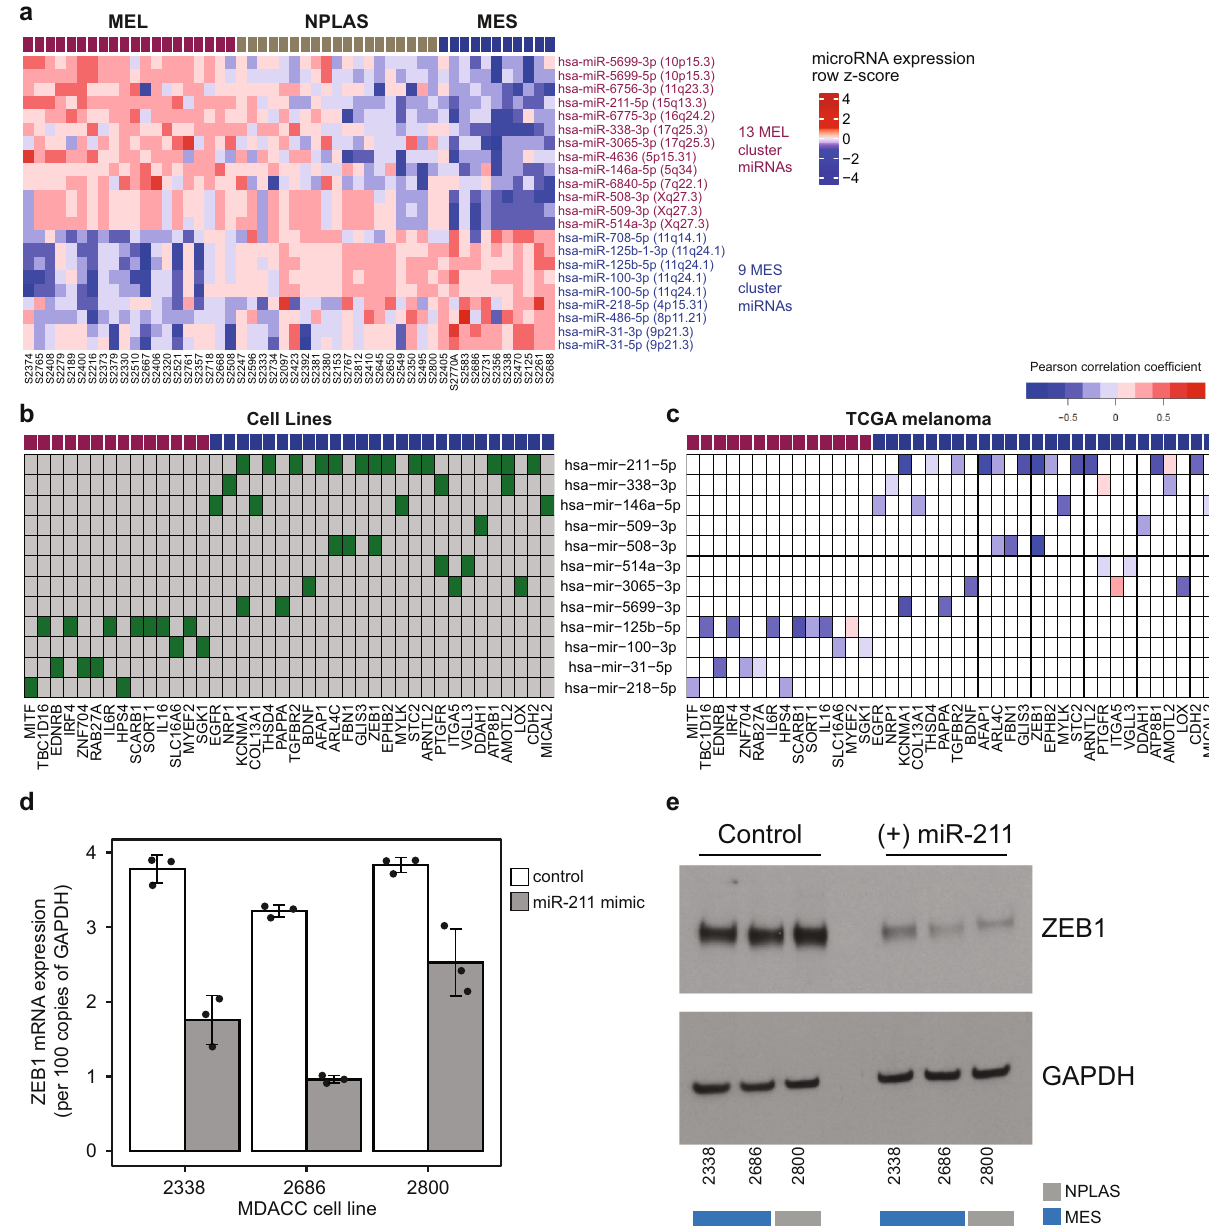
Fig. 5 Inverse associations between MEL and MES gene expression and mature strand miRs in cell lines are preserved in melanoma tumors. a Heatmap depicting expression of miRs differentially expressed between MEL and MES early passage MDACC melanoma cell lines ( n = 53). b Inverse Pearson correlations between abundances of miRs differentially expressed between MEL and MES samples, and the group of mRNAs con fi rmed by at least one experimentally validated and/or at least two in silico miR target databases to be targets of these miRs, in the early passage cell lines. More miRs targeting MES genes than MEL genes were identi fi ed; 8 active MES-targeting miRs (highly expressed in MEL samples) and 4 active MEL-targeting miRs (highly expressed in MES samples). c The majority of miR-mRNA associations identi fi ed in cell lines were also observed in TCGA melanoma tissue samples. d Effects of miR-211-5p overexpression in the cell lines indicated on ZEB1 mRNA expression. Bars depict mean + SD of three biological replicates under control (white bars) or miR-211-5p mimic (gray bars) treatment conditions. e Representative Western blot of ZEB1 protein expression in the cell lines indicated comparing control and miR-211-5p overexpression conditions. Source data are provided as a Source Data fi